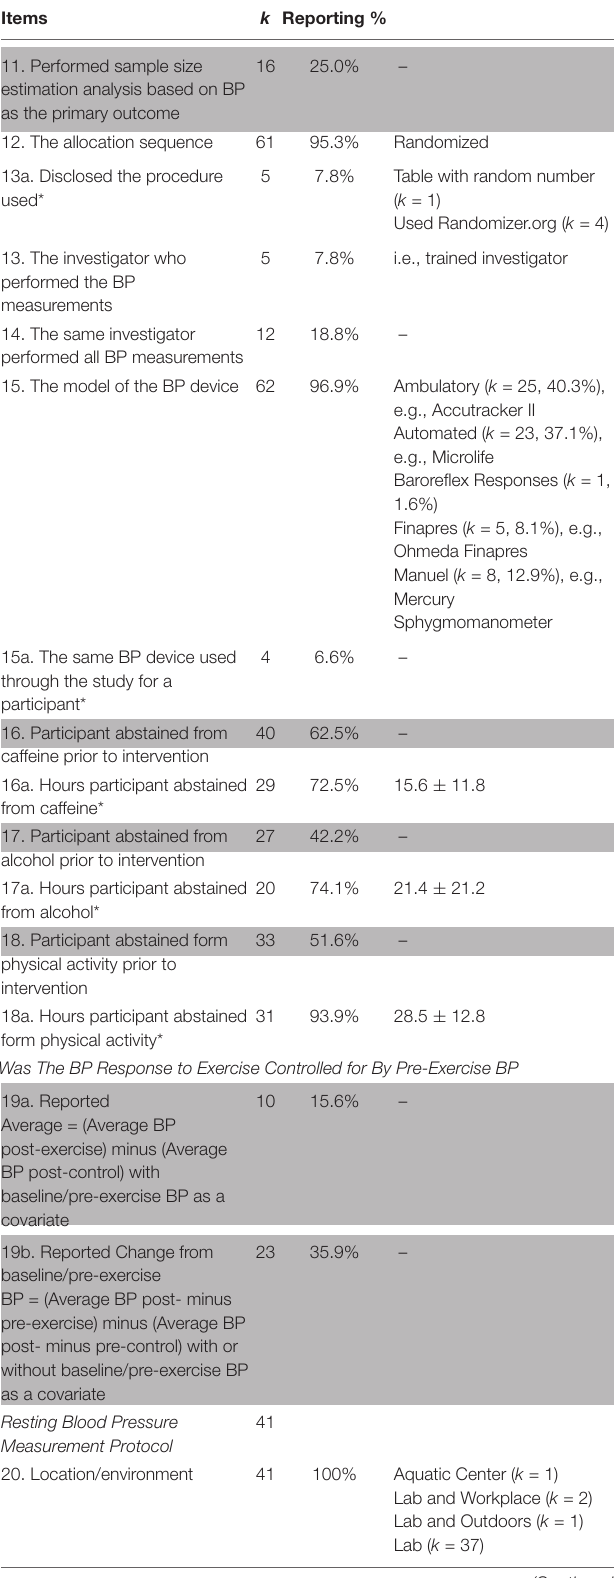
√ list part one participant characteristics. TABLE 2 | PEH TABLE 1 | PEH